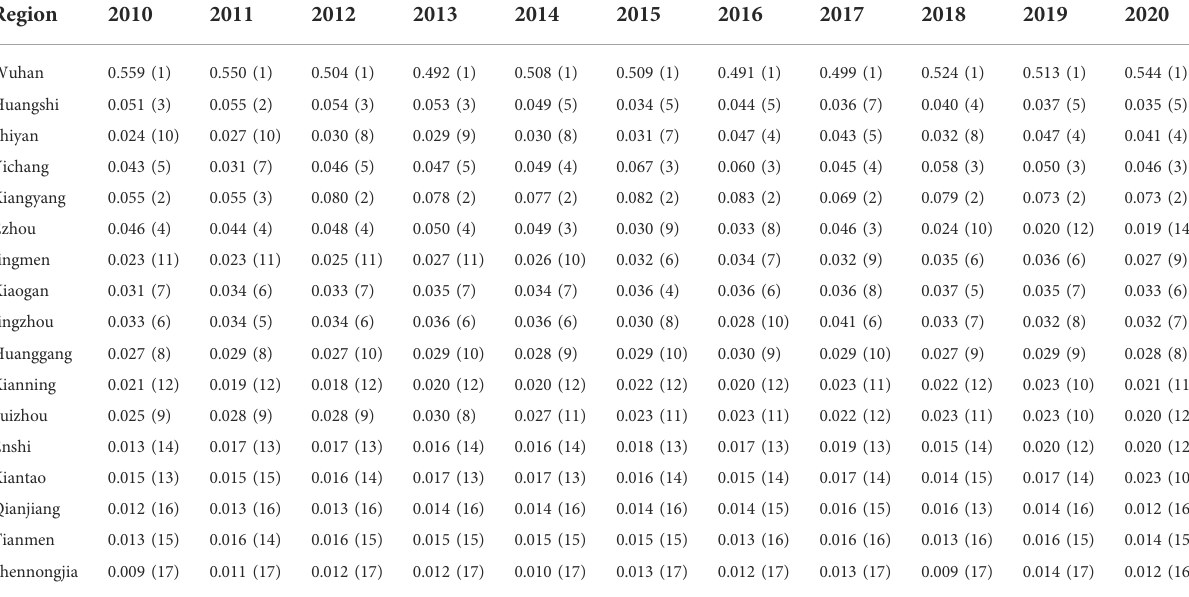
TABLE 2 Comprehensive index and ranking of high-quality development of Hubei provinces (2010 – 2020).